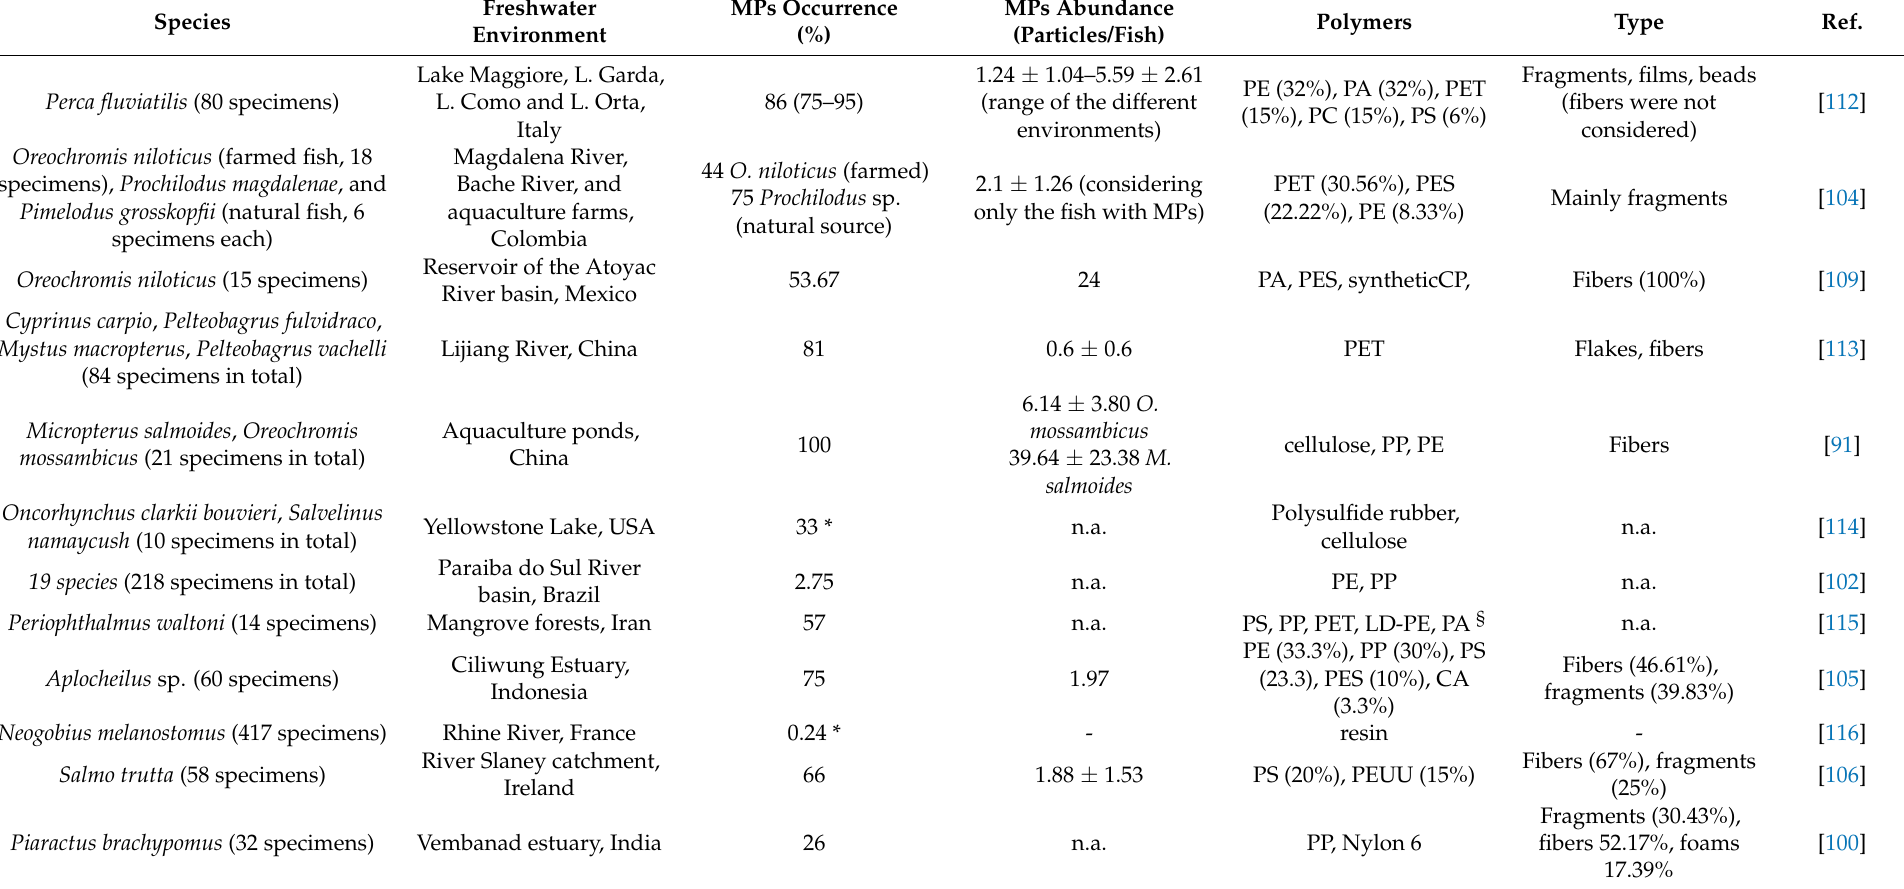
Table 1. Overview of studies investigating the MPs gut/stomach content in wild freshwater fishes. MPs presence is indicated as MPs per individual (particles/fish). For each study, the species investigated, the number of specimens analyzed, the environment sampled, and the values of MPs occurrence, abundance, polymer, and are reported. When available, ranges of MPs concentration among different species or sampling sites are reported as well as polymers identified and morphologies. In order to be comparable, only studies involving one step of chemical confirmation of the synthetic nature of the particles counted are